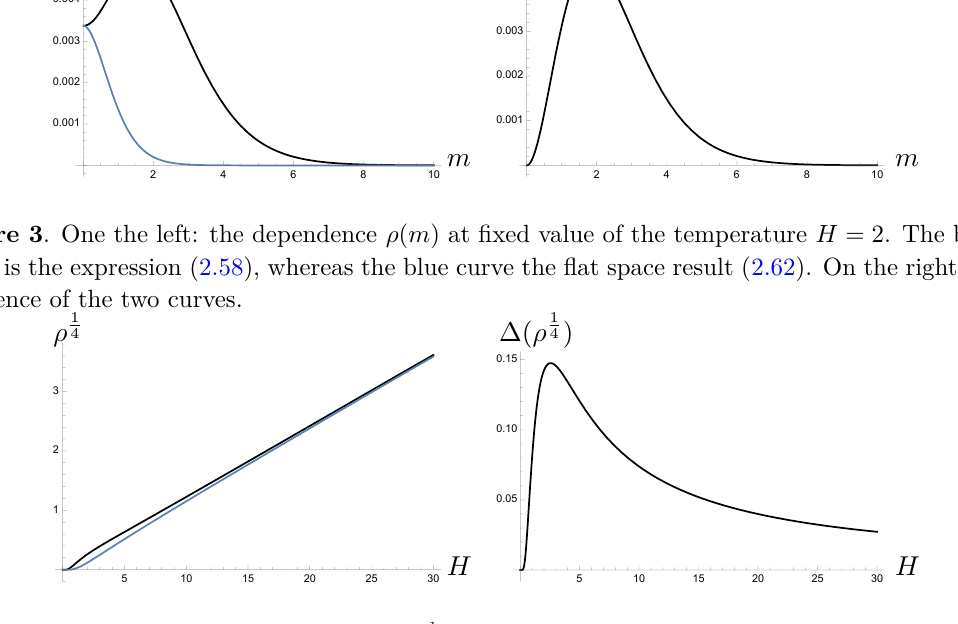
Figure 4 . One the left: the dependence ρ 1 4 ( H ) at fixed value of the mass m = 2 . The black curve is the expression (2.58), whereas the blue curve the flat space result (2.62). On the right: the difference of the two